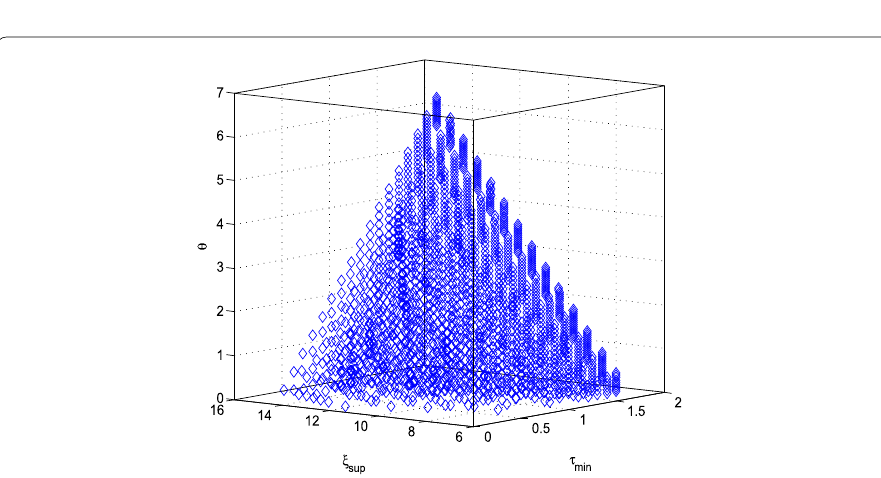
Figure 3 Control input signals